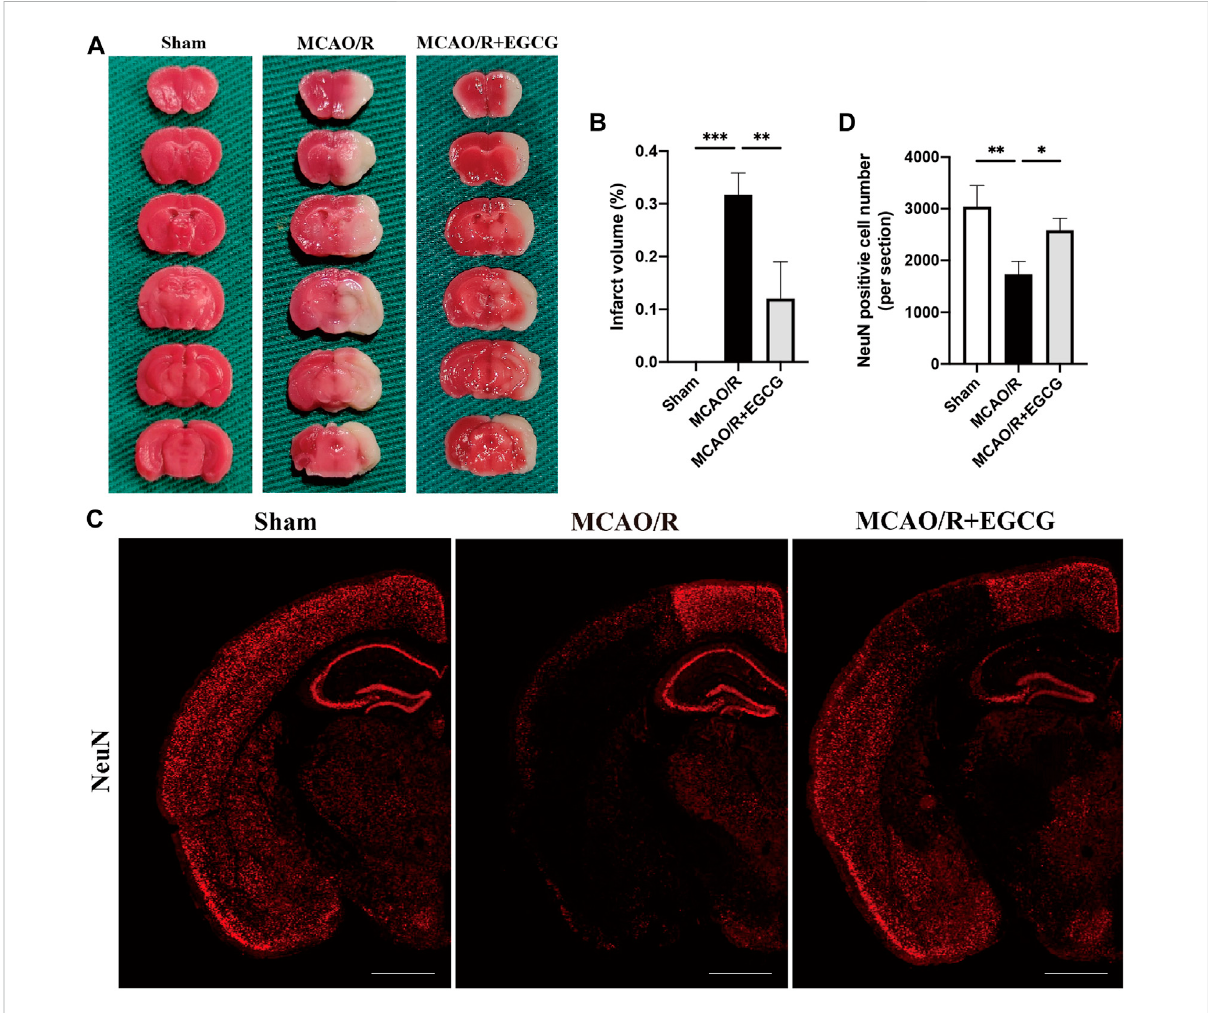
FIGURE 1 EGCG treatment mitigated cerebral ischemia/reperfusion injury (CIRI) in the mice model of middle cerebral artery occlusion/reperfusion (MCAO/R). (A,B) 2, 3, 5-Triphenyltetrazolium chloride (TTC) staining assay was performed to evaluate the infarct volume. (C,D) Immuno fl uorescent staining for NeuN. Data were shown in the semi-brain from the ipsilateral side of surgery on post-surgery day (PSD) 1 (scale bar = 1,000 μ m). Each experimental datum was presented as mean ± standard deviation ( n = 3 animals per group). * p < 0.05, ** p < 0.01, *** p < 0.001 versus the speci fi ed